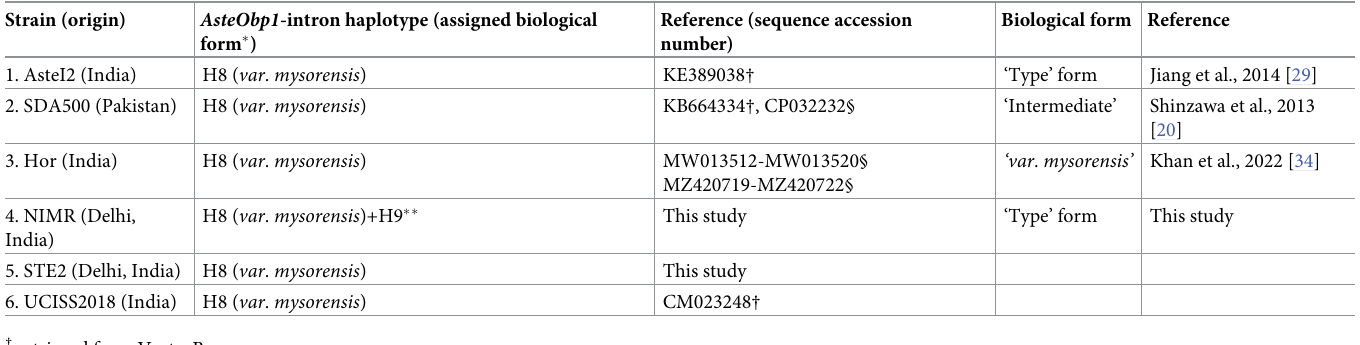
Table 3. AsteObp1- intron haplotypes in different laboratory strains of An . stephensi maintained and their biological forms. Strain